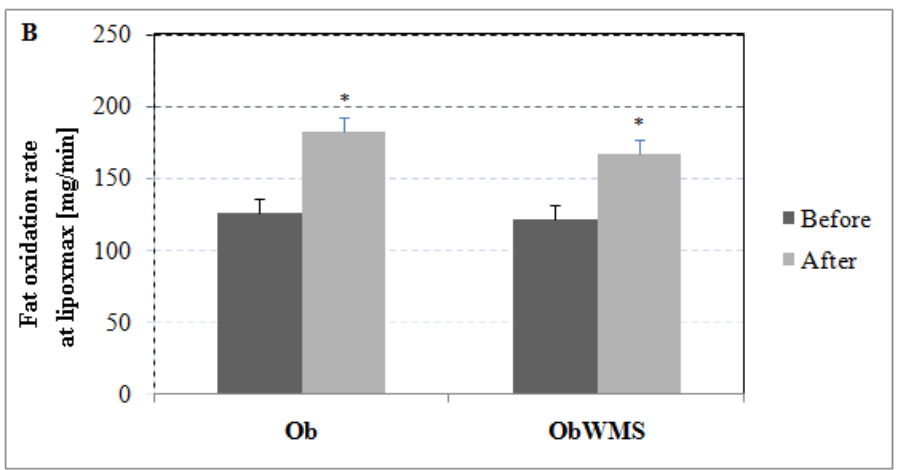
Figure 1. Effect of physical training on maximal lipid oxidation (Lipoxmax) during exercise: ( A ) Lipoxmax expressed in watts. ( B ) Rate of fat oxidation at Lipoxmax, expressed in mg/min. * pre vs. post training at P < 0.001, Ob: obese without metabolic syndrome, ObWMS: obese with metabolic syndrome.